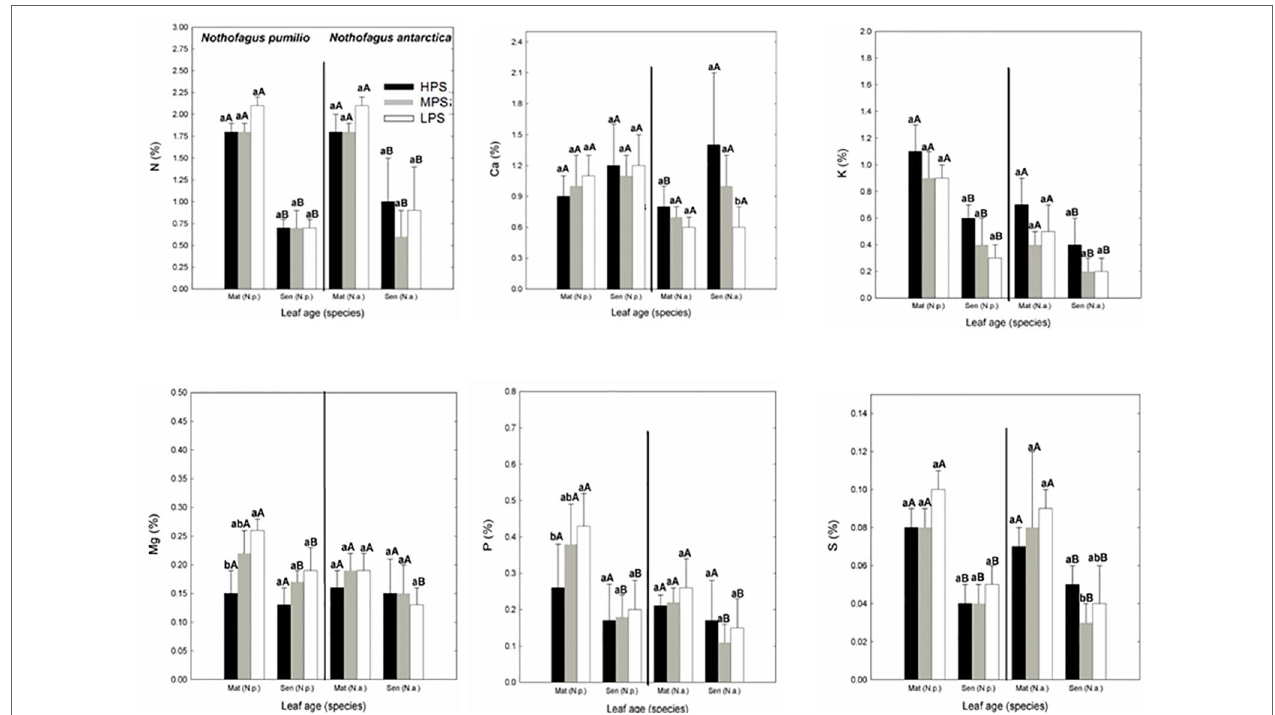
FiGURE 1 | Macronutrient (N, P, Ca, K, Mg, and S) concentrations of N. pumilio and N. antarctica leaves from three contrasting sites, collected at two developmental stages (mature and senescent). HPS, highly productivity site; MPS, medium productivity site; LPS, low productivity site. N.p., Nothofagus pumilio ; N.a., Nothofagus antarctica ; Mat, mature leaves; Sen, senescent leaves. Different lower case letters for the same species and age of leaves (mature or senescent) indicate significant differences (P < 0.05) between sites. Different capital letters for the same species and site indicate significant differences (P < 0.05) between age of leaves (mature or senescent). Bars represent the standard deviation of the